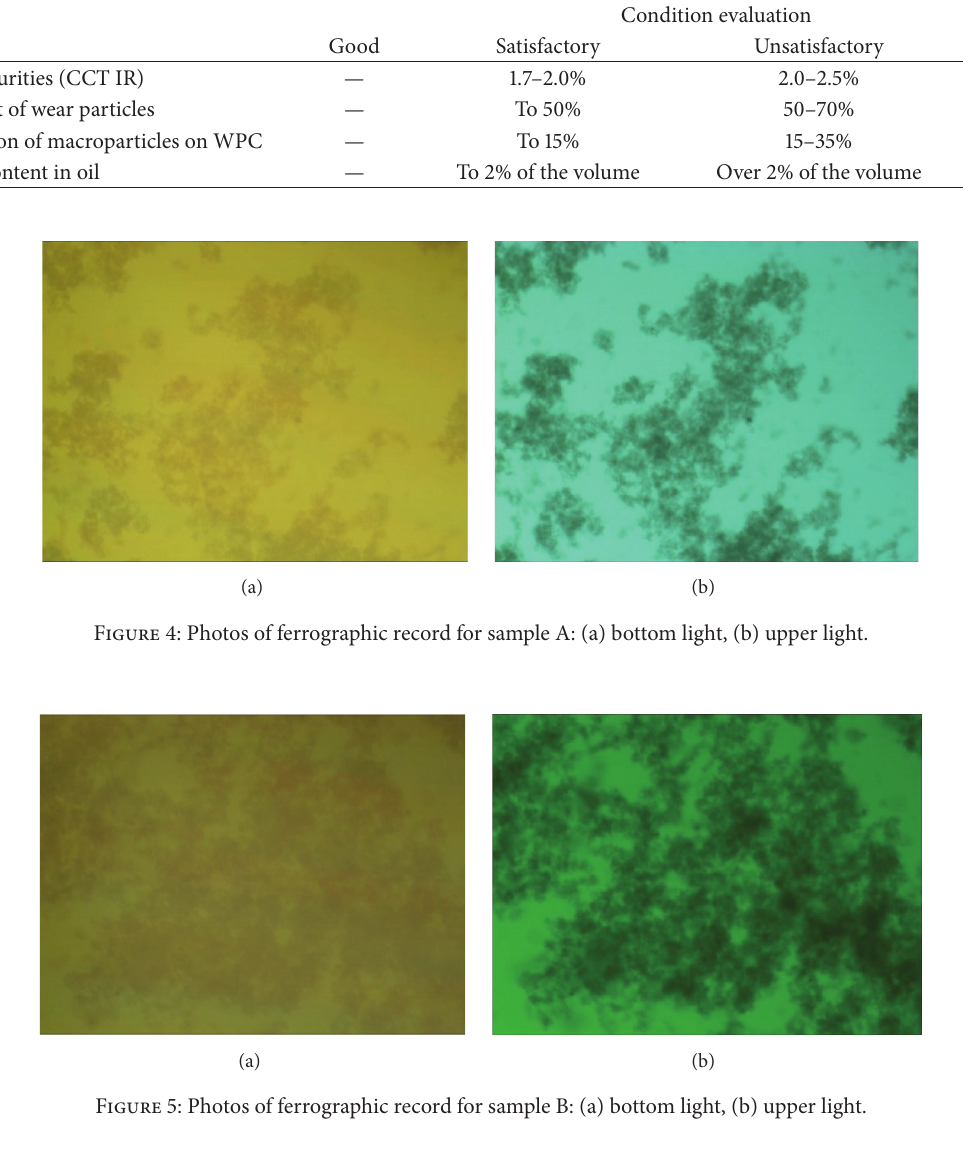
Table 2: Evaluation of the lubricant condition.